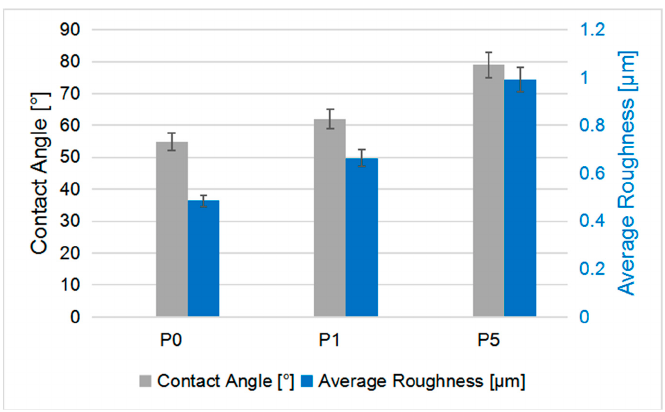
Figure 7. Contact angle and surface roughness values